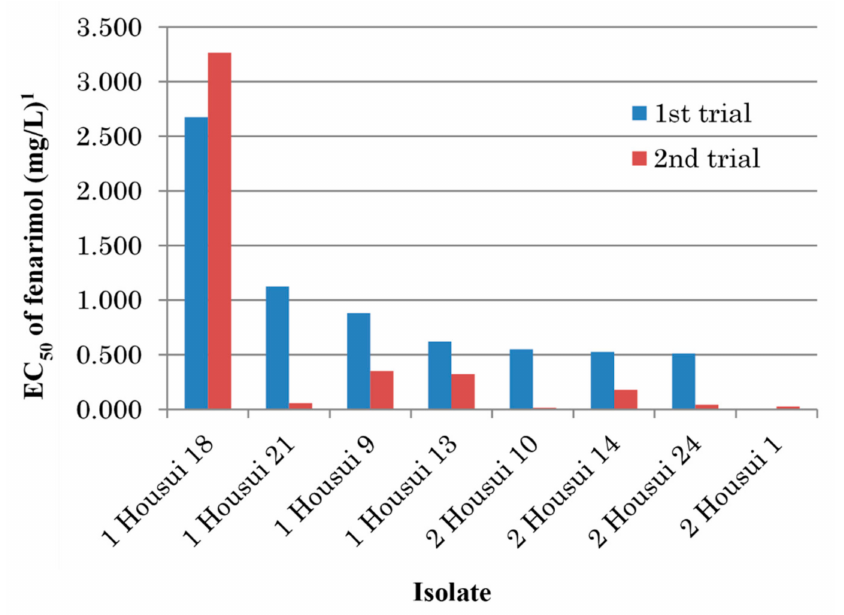
Figure 2. Change of fenarimol sensitivity in single-spore isolates of Venturia nashicola after storage at 4 ◦ C in absence of the fungicide. 1 Average values of two